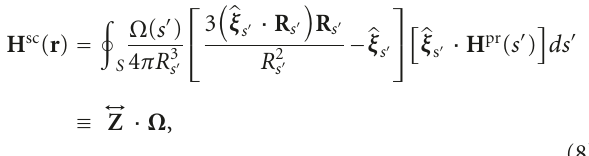
Figure 3: Total NSMS amplitudes Q ( t ) of the 216 Camp Sibert anomalies as a function of time. The 25 time gates are distributed approximately logarithmically between 191 μ s and 25ms. The Q - values are shown in the same colors and with the same markers as in subsequent figures, with the black line denoting the median Q for each group. The 15th time channel, corresponding to t = 2 . 72 ms, is highlighted; the ratio R ≡ Q ( t 15 ) /Q ( t 1 ) has been found to be a robust classifier. The gray pentagons correspond to Cell no. 7, which we study in detail in the main text. The thinner dotted lines show the two false alarms from Figure 6, also depicted on Figure